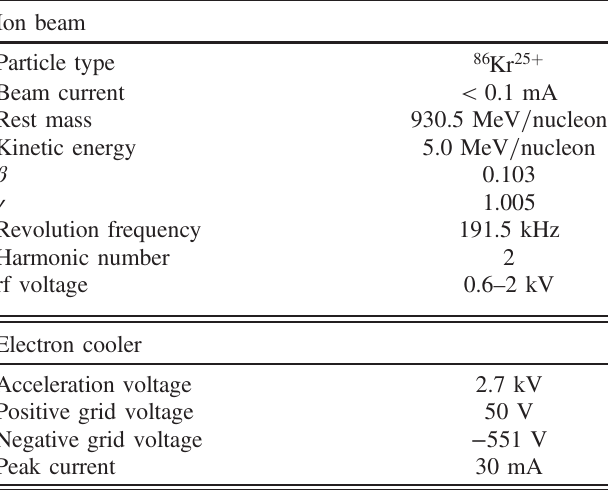
TABLE I. Beam and instrumentation parameters.